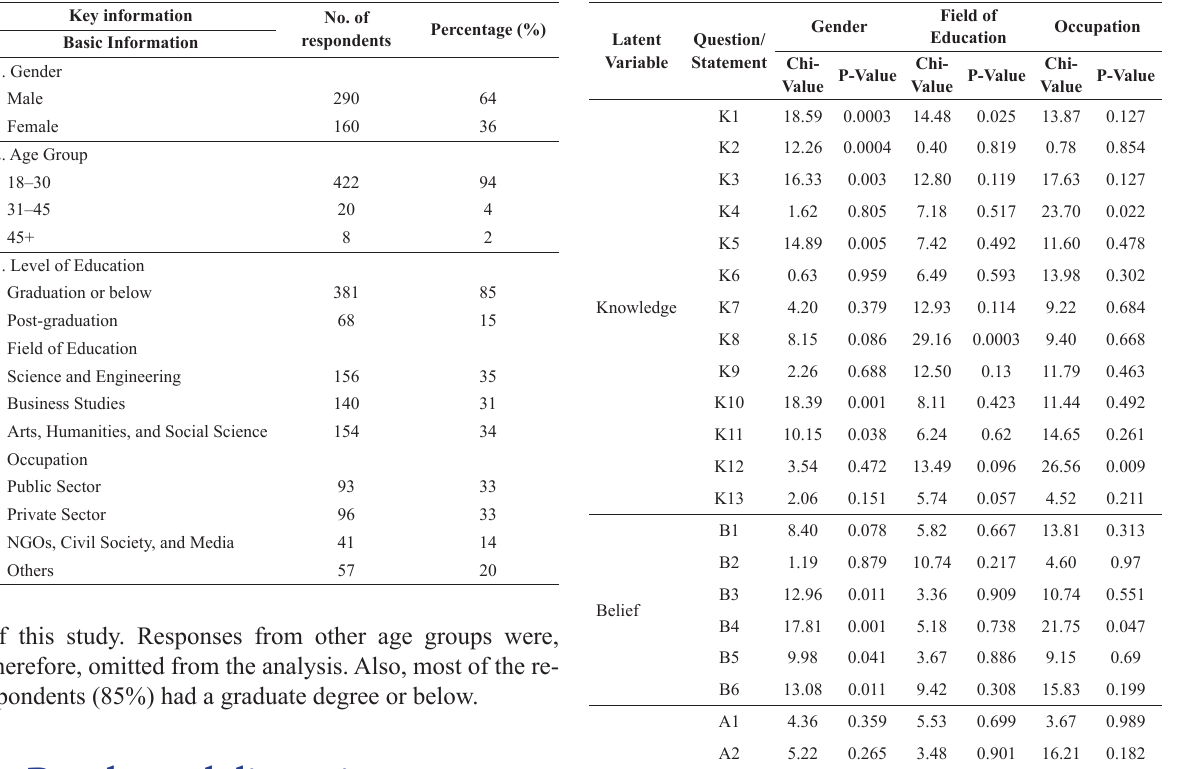
Table 3. Socio-demographic variables of the respondents Table 4. Results from Chi-squared